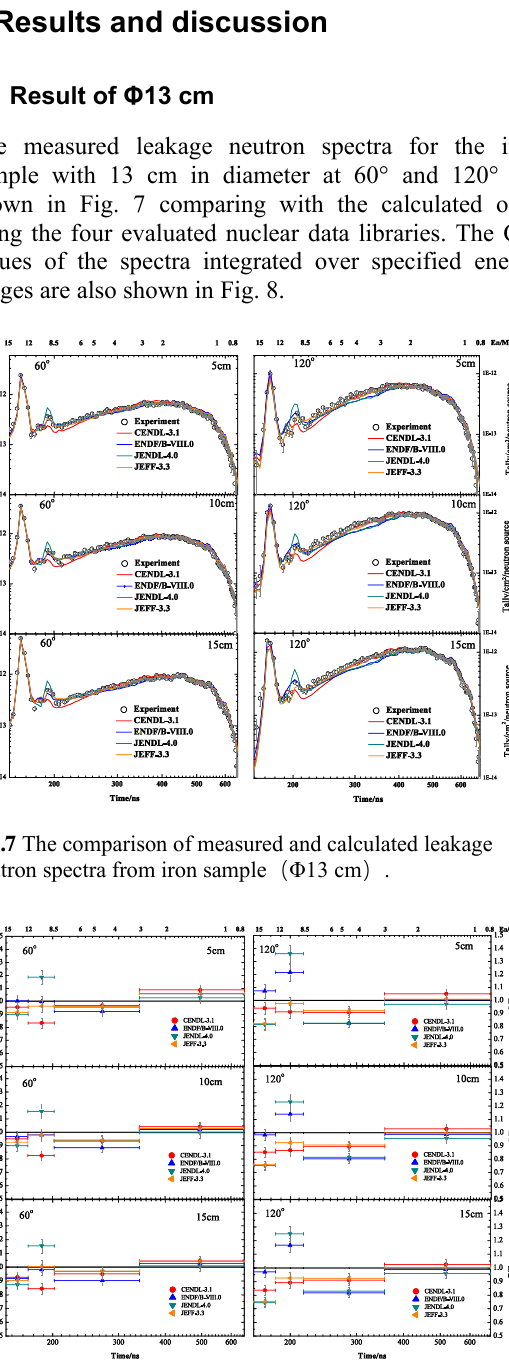
Fig.5 Model for the MCNP calculations with sample surface area of Φ13 cm.